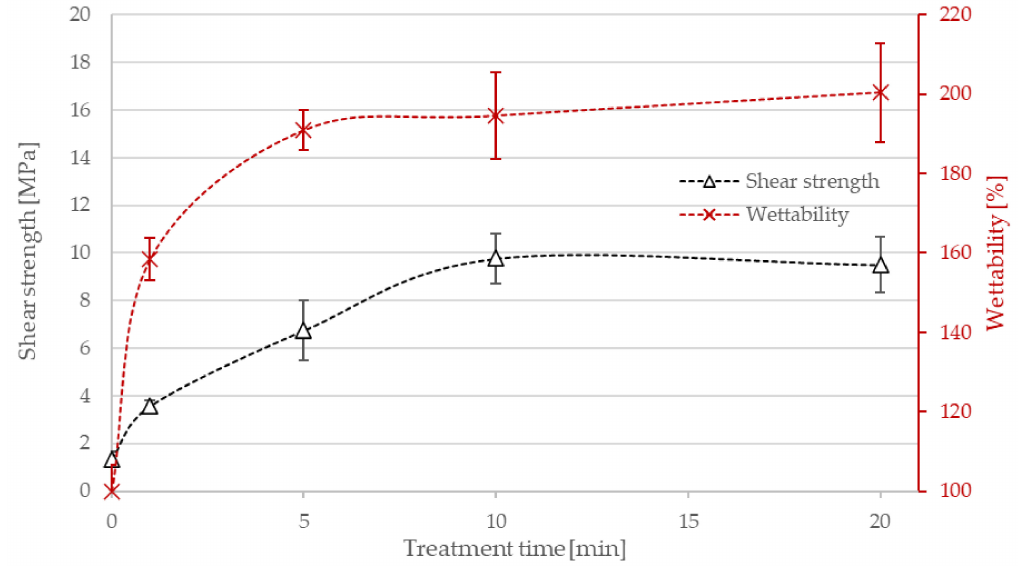
Figure 2. The wettability, shear strength and chemical bond surface concentration of PE powder versus the treatment time using air